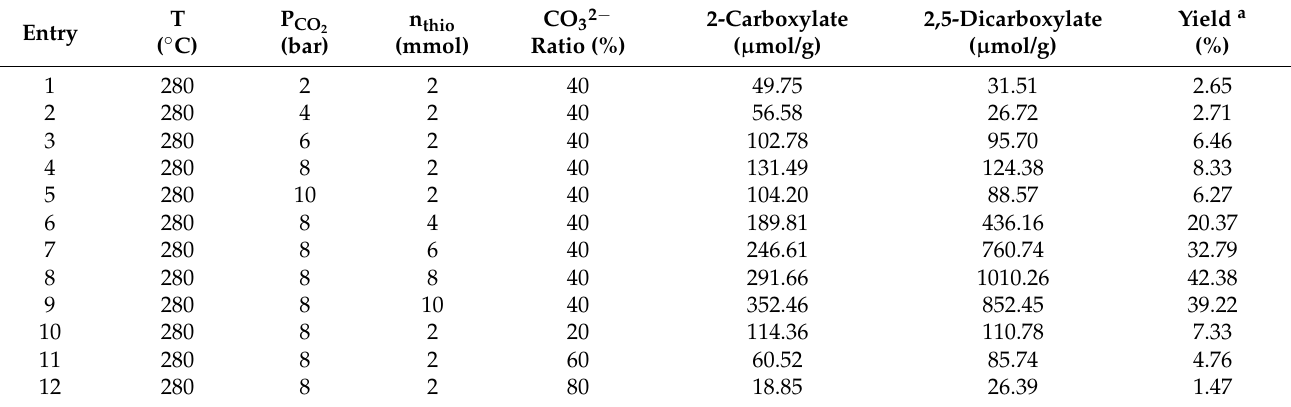
Table 2. The effects of various factors on the product yield and selectivity in the Cs 2 CO 3 /CsOPiv